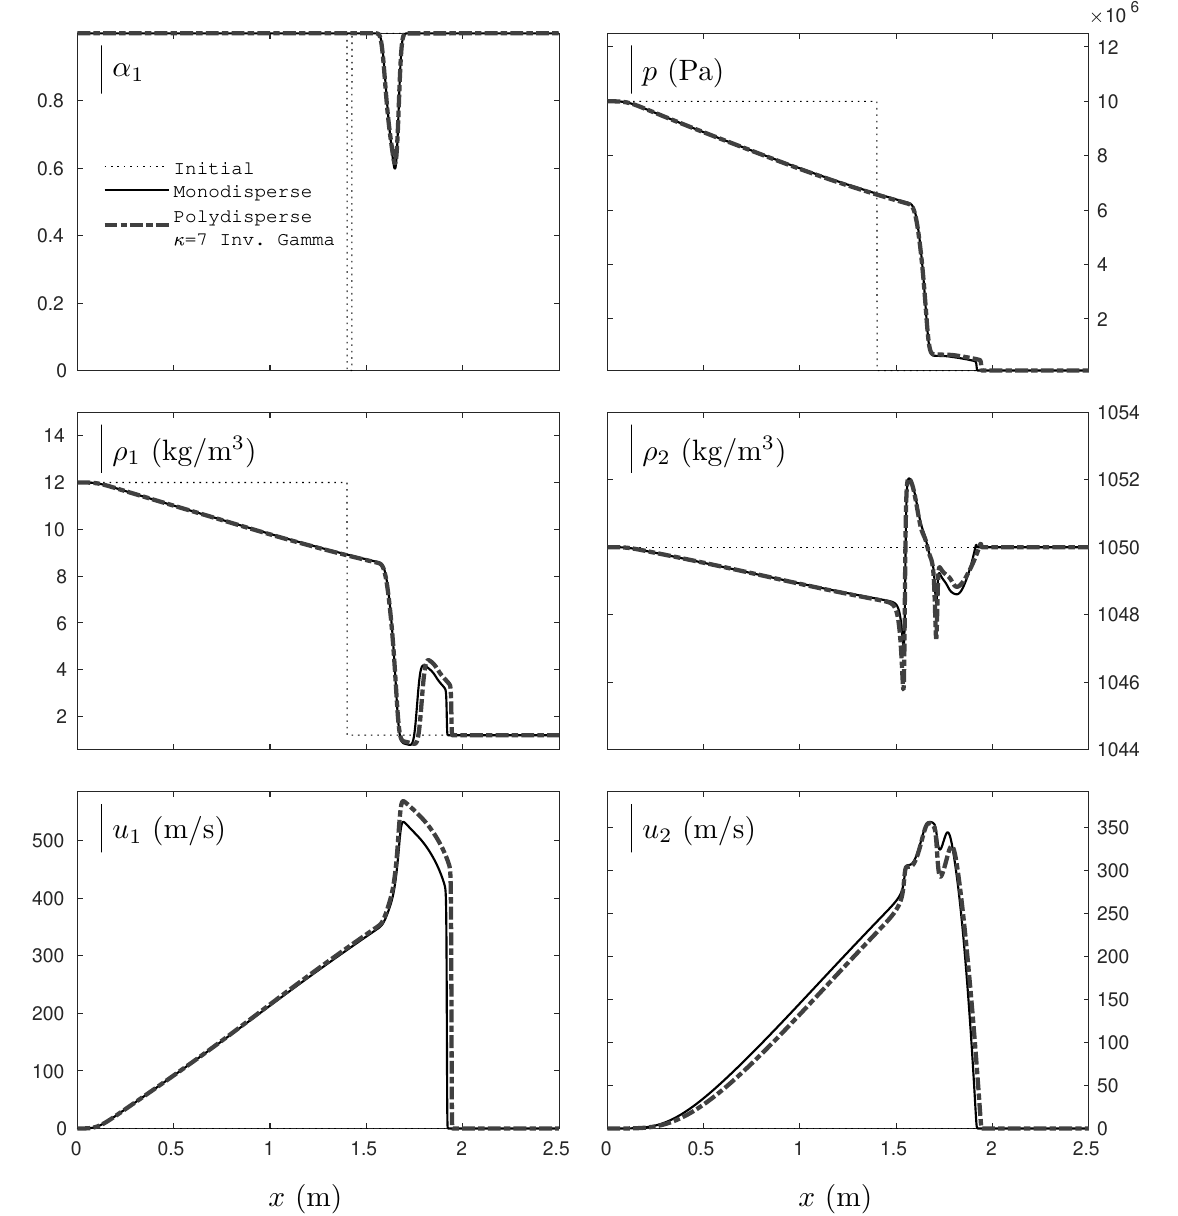
Figure 16: Simplified two-phase explosion test depicted in Fig. 5. Comparison of the monosdisperse and polydisperse results. Figure 16. Simplified two-phase explosion test depicted in Figure 5. Comparison of the monodisperse t = 0 = R t = 0 = and polydisperse results. The initial mean radius is the same for both computations R 2 The initial mean radius is the same for both computations R 2 t =0 = R t =0 = 30 µ m. For the polydisperse computation, the 2 2 30 µ m. For the polydisperse computation, the Inverse Gamma distribution is used with κ = 7. All Inverse Gamma distribution is used with κ = 7. All results are given at time t = 1 . 2 ms and are presented in terms of α 1 , p , results are given at time t = 1.2 ms and are presented in terms of α 1 , p , ρ 1 , ρ 2 , u 1 and u 2 for both ρ 1 , ρ 2 , u 1 and u 2 for both computations. Differences between the two solutions are visible. computations. Differences between the two solutions are